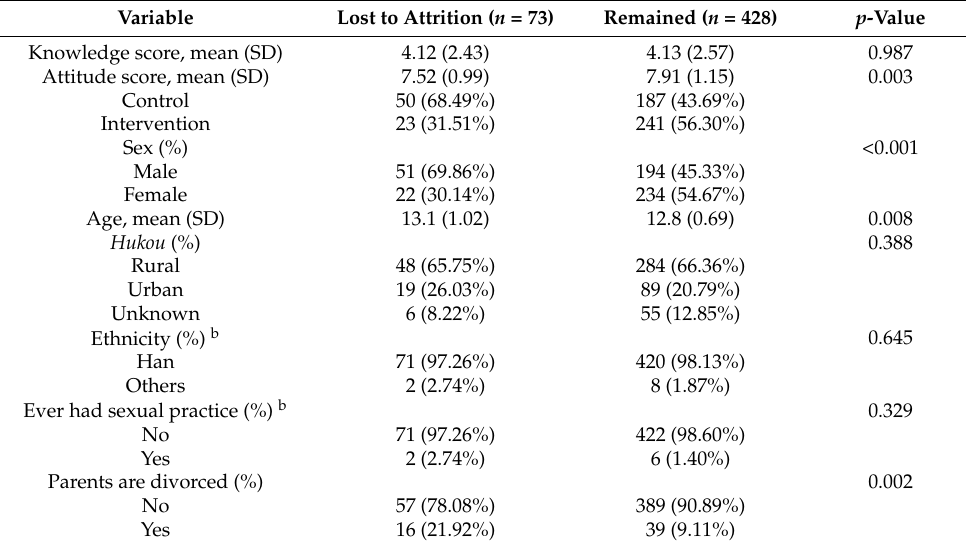
Table 2. Baseline characteristics comparison between students remained and students lost to follow-up a